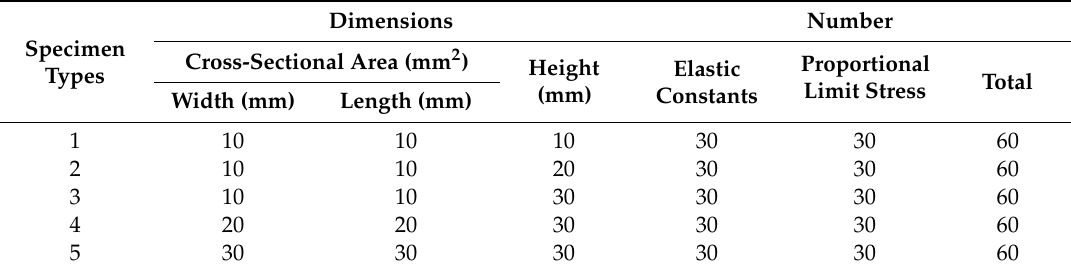
Table 1. Configurations of specimens used to measure elastic mechanical properties of